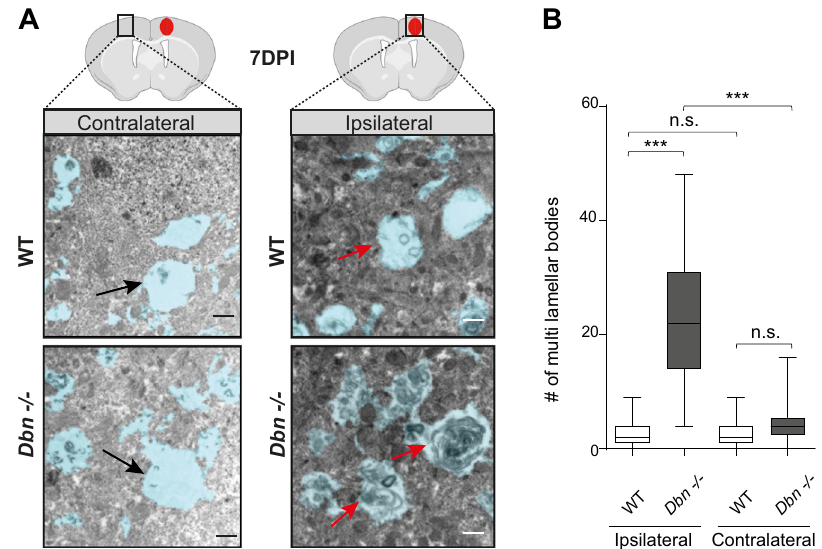
Fig. 6 DBN loss induced membrane accumulations in polarizing astrocytes during injury. A TEM ultrastructural architecture of astrocytes in brains of WT and Dbn − / − mice. Images were acquired on the contralateral side of injury (left panels) or inside the lesion core (right panels); 7 days post stab injury (7 DPI). Astrocyte processes are shaded in blue. Black arrows show astrocyte processes largely devoid of membranous compartments, on the site contralateral to the stab injury. Red arrows show astrocyte processes at the injury site with endosome-like organelles (WT, upper image) or with multilamellar bodies ( Dbn − / − , bottom image). Scale bars: 500 nm. B Quanti fi cation of multilamellar bodies displayed as box and whisker plots: box extends from 25th to 75th percentiles, central line = median, whiskers comprise all values from minimum to maximum. Field of view size: 1170 µ m². Number of fi elds/view: 92 WT and 77 Dbn − / − ipsilateral, 85 WT and 77 Dbn − / − contralateral from three WT and three Dbn − / − animals (Bartlett ’ s test for equal variances *** P < 0.001; one-sided Kruskal – Wallis test with Dunn ’ s multiple comparisons test *** P < 0.001; multiplicity adjusted p values: Ipsilateral WT vs Ipsilateral Dbn − / − : P = 0.000000000000047; ipsilateral WT vs contralateral WT: P = 0.999999999999999; contralateral WT vs contralateral Dbn − / − : P = 0.190172692939112; Ipsilateral Dbn − / − vs contralateral Dbn − / − : P = 0.000000755492543). Source data are provided as a Source Data fi